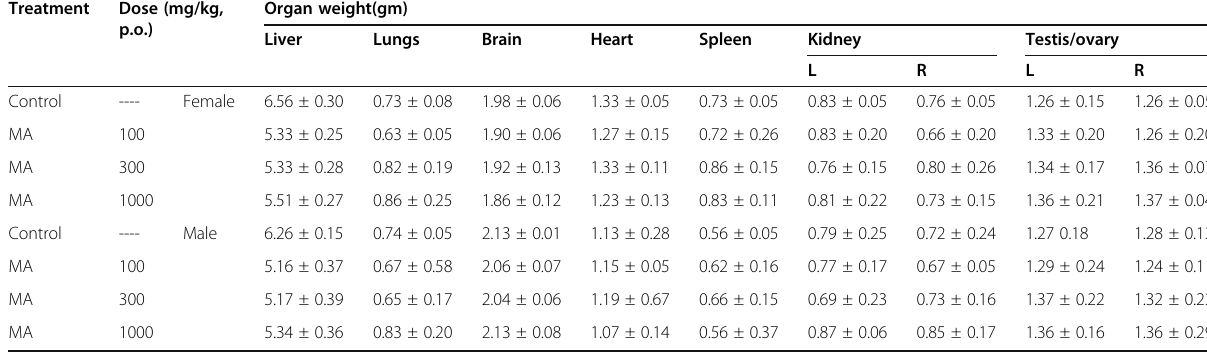
Table 3 Organ weights of rats administered orally with MA for a period of 28 days Treatment Dose (mg/kg, p.o.)